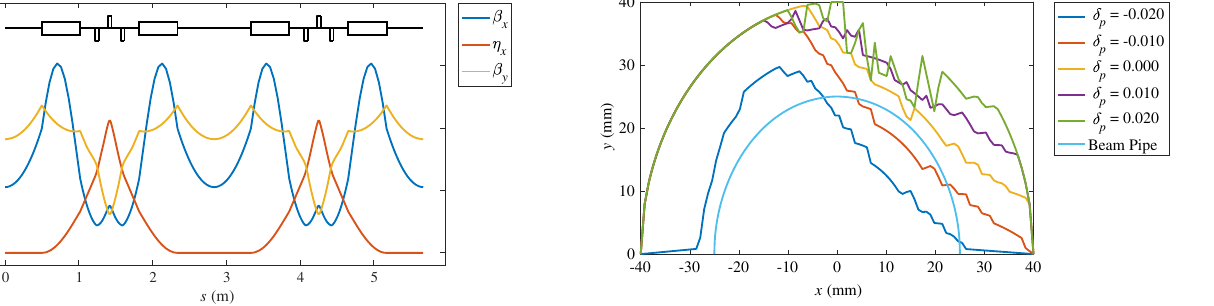
FIG. 5. Layout of the compact electron ring with betatron amplitude functions and horizontal dispersion function.